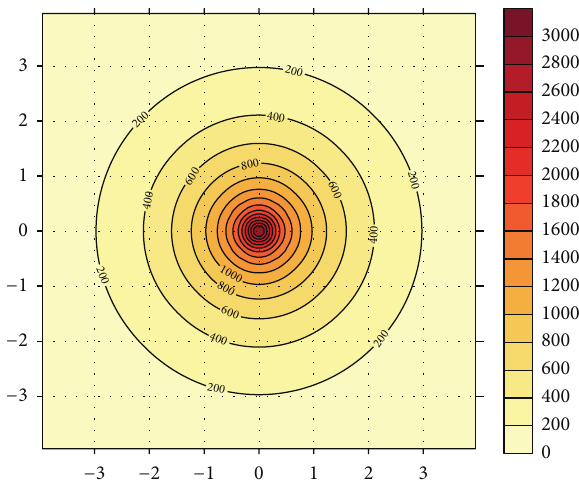
Figure 13: 3000 ∘ C thermal